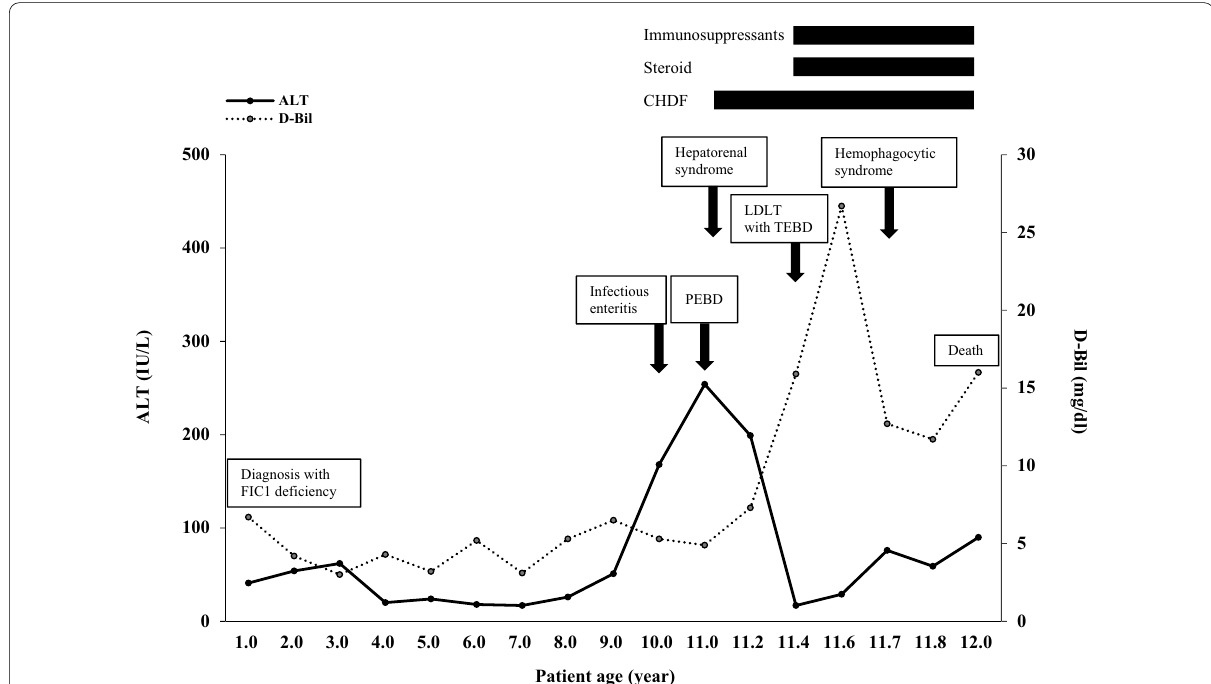
Fig. 1 Clinical course of the patient with FIC1 deficiency (case 1). FIC1 progressive familial intrahepatic cholestasis 1, ALT alanine aminotransferase, D-Bil direct bilirubin, CHDF continuous hemodiafiltration, PEBD partial external biliary diversion, LDLT living-donor liver transplantation, TEBD total external biliary